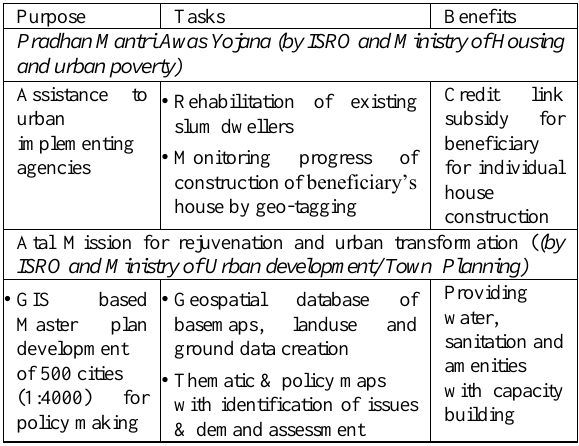
Table-1. Projects related to urban